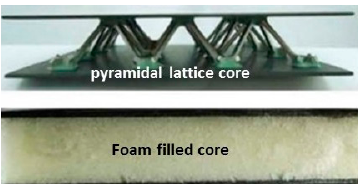
Figure 2. Studied composite panel by Zhang et al. Adapted from [8].